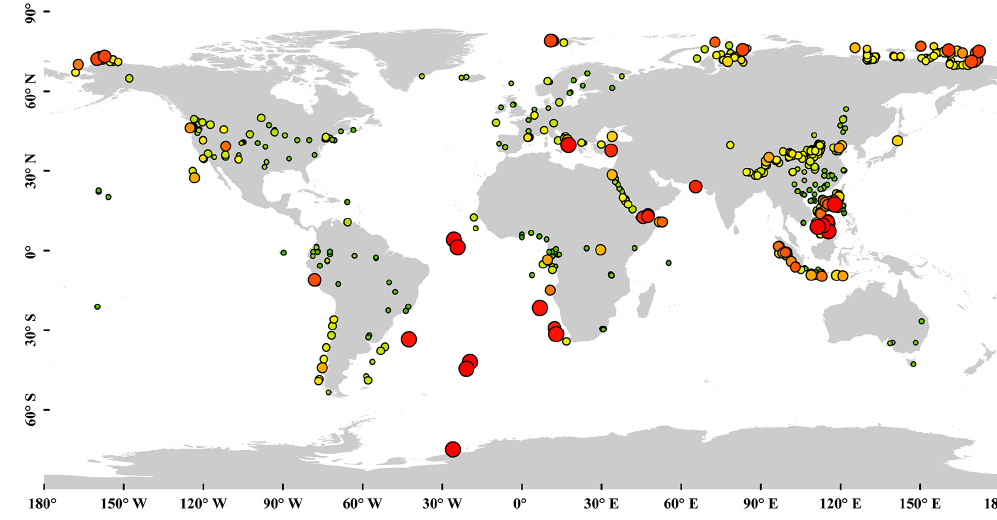
Figure 5. Global distribution pattern of brGDGT IIIa / IIa ratio in soils and marine sediments.